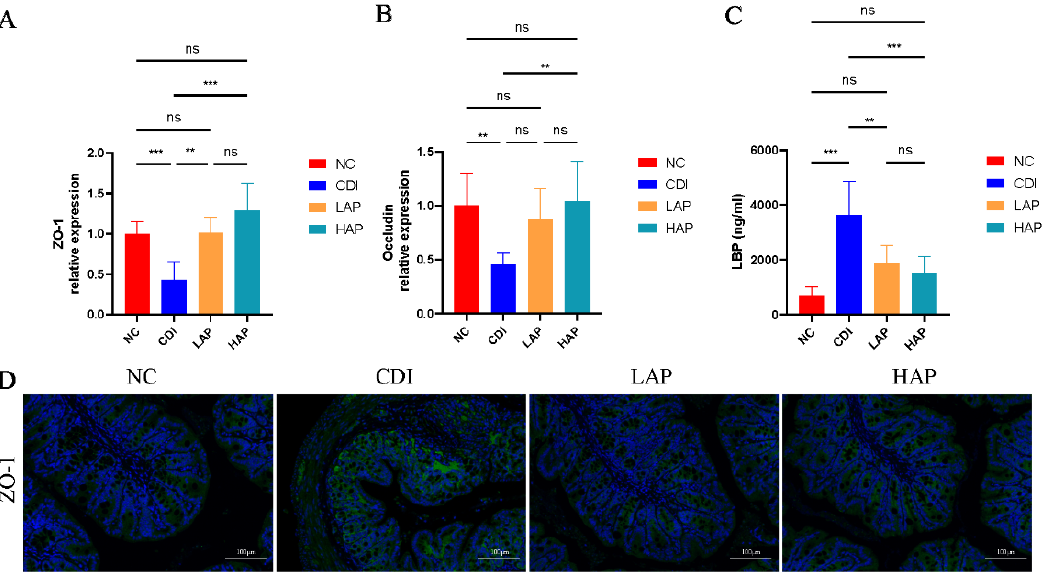
Figure 3. APE protects intestinal barrier function. ( A , B ) Relative mRNA expression of ZO-1 and occludin in colon tissue. ( C ) Serum LBP levels. ( D ) Representative immunofluorescence staining of ZO-1 in the colon. Data are expressed as mean ± SEM. ** p < 0.01, *** p < 0.001.